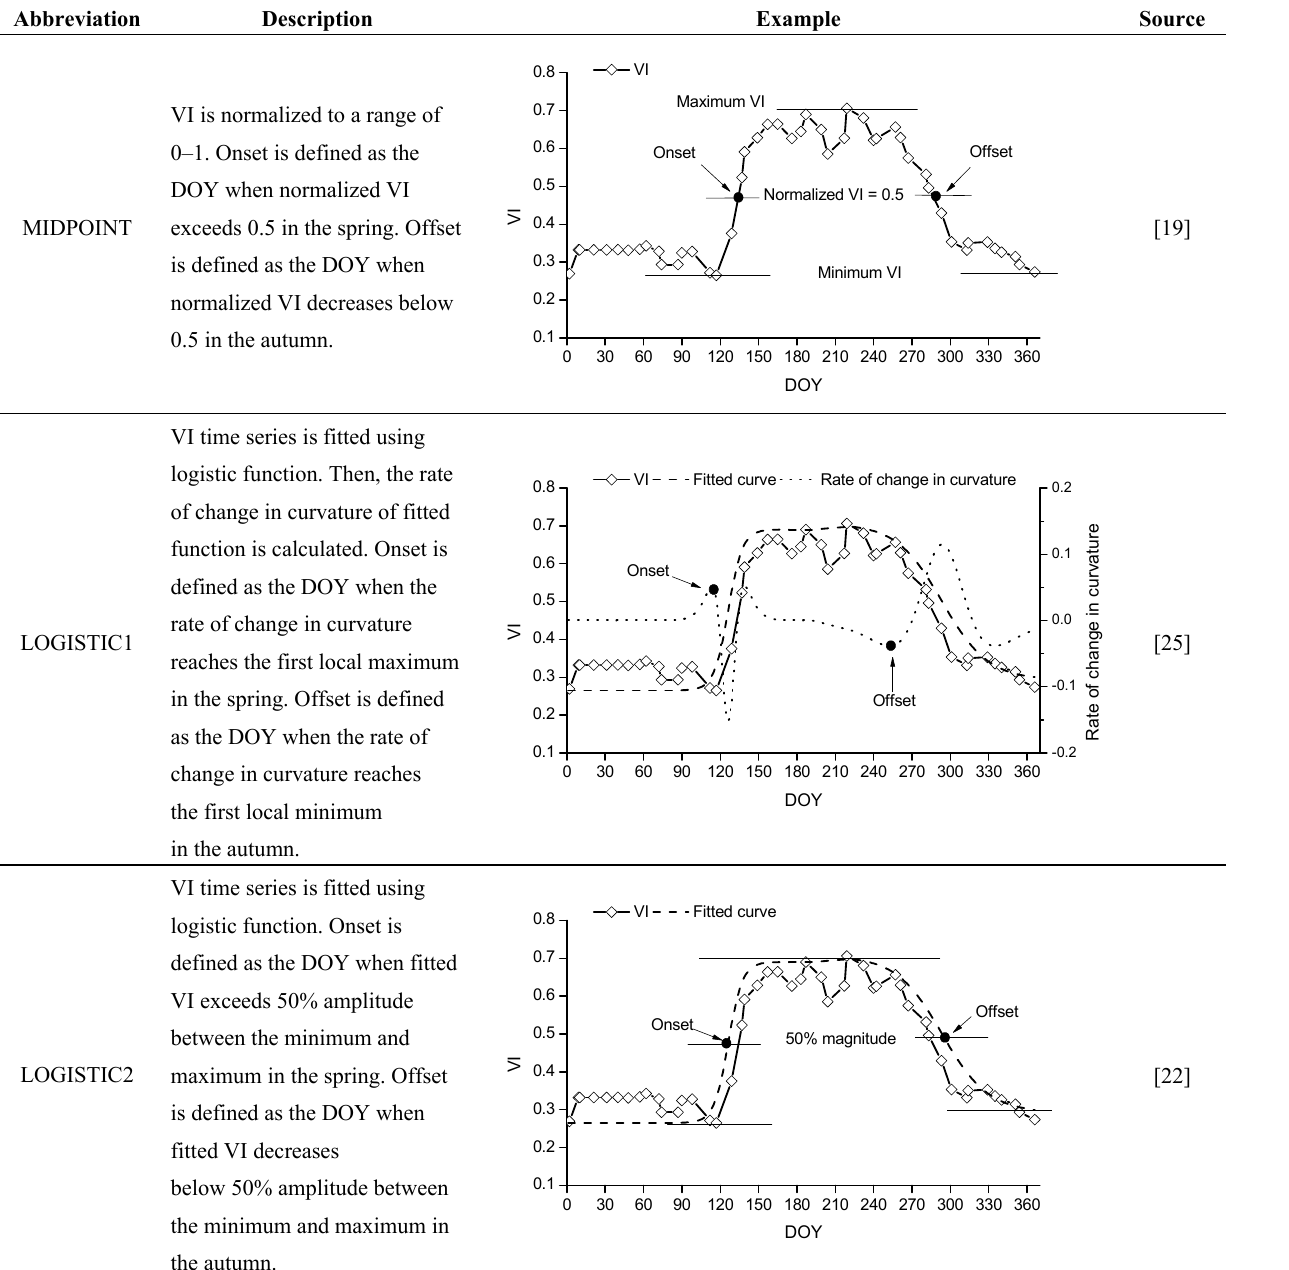
Table 1. Description of the remote sensing methods for retrieving